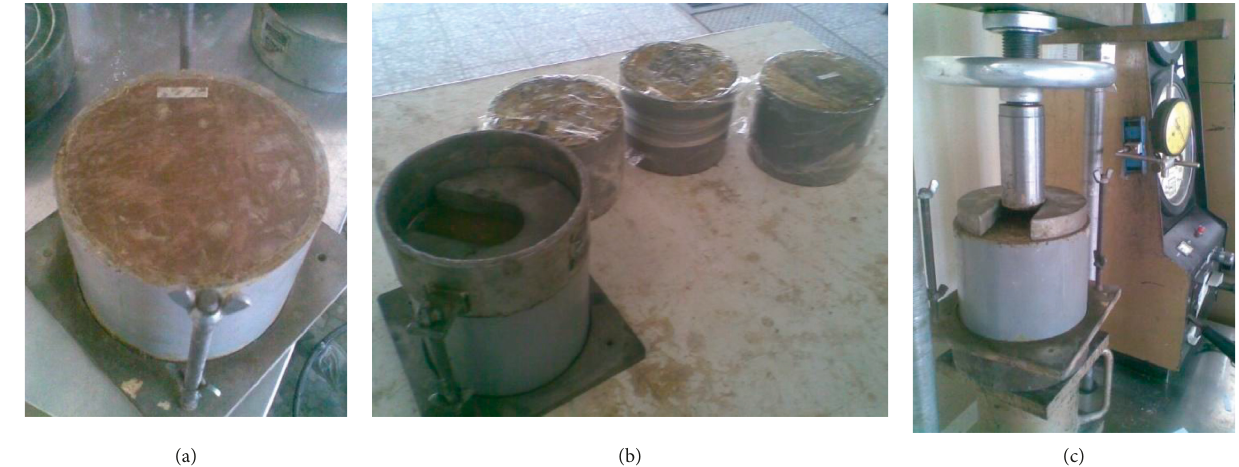
Figure 4: California bearing ratio test: (a) mould, (b) samples after 7days of curing, and (c) California bearing ratio test apparatus.